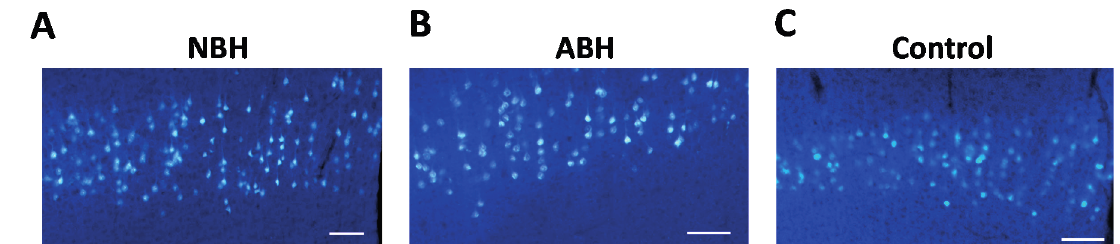
Figure 4. Retrograde tracing study. The corticospinal neurons in the right cerebral cortex were retrogradely labeled by FG in the 1 mm from bregma ( A : NBH; B : ABH; C : control). The number of FG labeled neurons in the right cerebral cortex ( D ). Top means frontal pole and 0 mm means bregma level. The scale bar = 100 µm ( A – C ). ** p ＜ 0.01, * p ＜ 0.05, Kruskal-Wallis test followed by Steel-Dwass